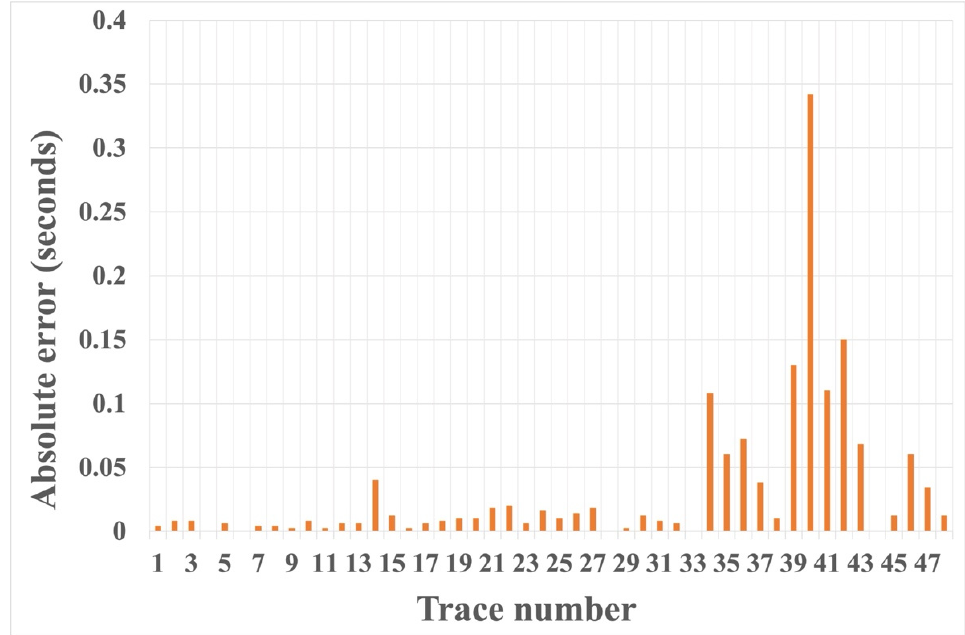
Figure 12. Absolute error between first arrival picks determined by the HEEH method and manually for Yilmaz record number 22.